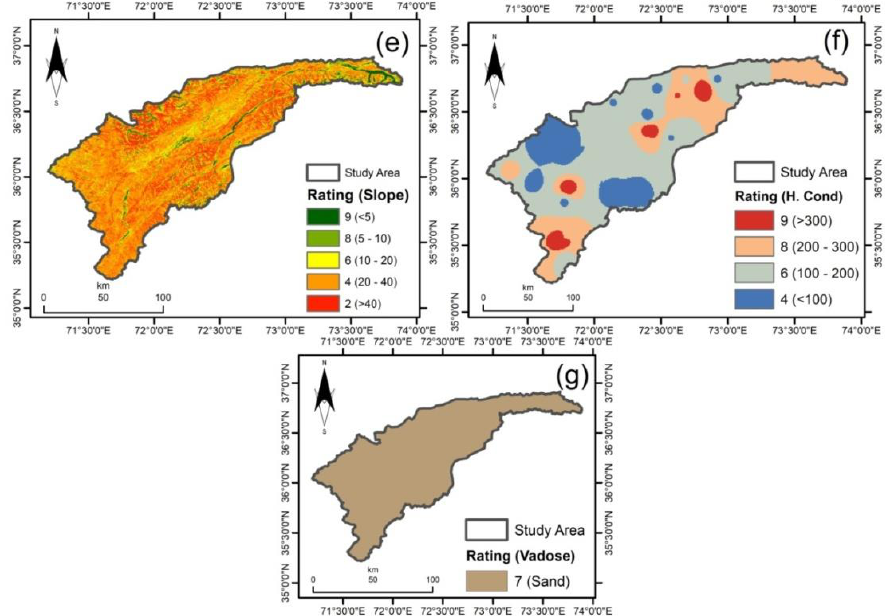
Figure 3. Seven thematic layers for DRASTIC model: ( a ) depth to water table, ( b ) net recharge, ( c ) aquifer media, ( d ) soil media, ( e ) slope, ( f ) impact of vadose zone, ( g ) hydraulic conductivity.